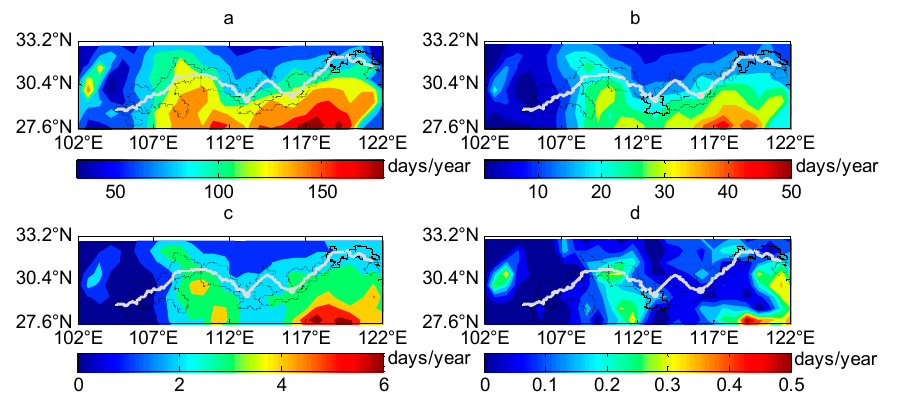
Figure 2. Number of days with the Heavy rain (( a ) slight risk, ( b ) middle risk, ( c ) high risk and ( d ) extreme risk) during the period 1979–2017 based on ERA-Interim Reanalysis data.